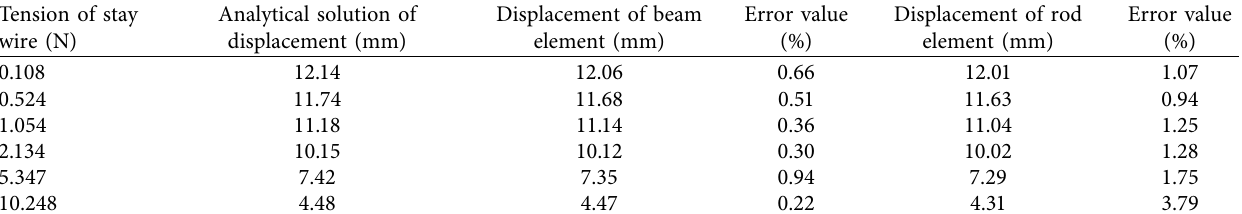
Table 7: Comparison table of numerical calculation of beam element and bar element under different tension of stay wire. Tension of stay wire (N)